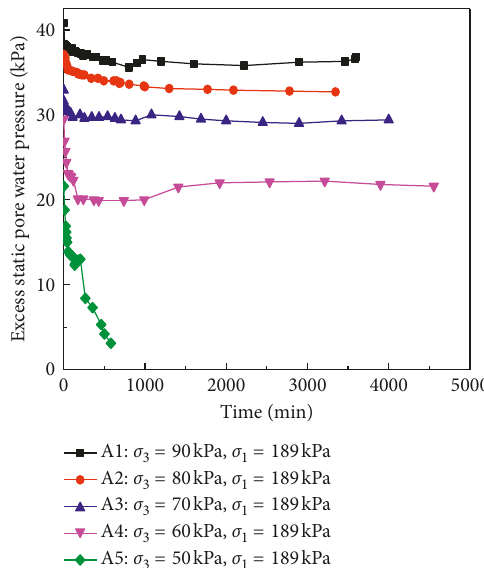
Figure 5: The pore water pressure-time curve at initial excess pore water pressure (40kPa).